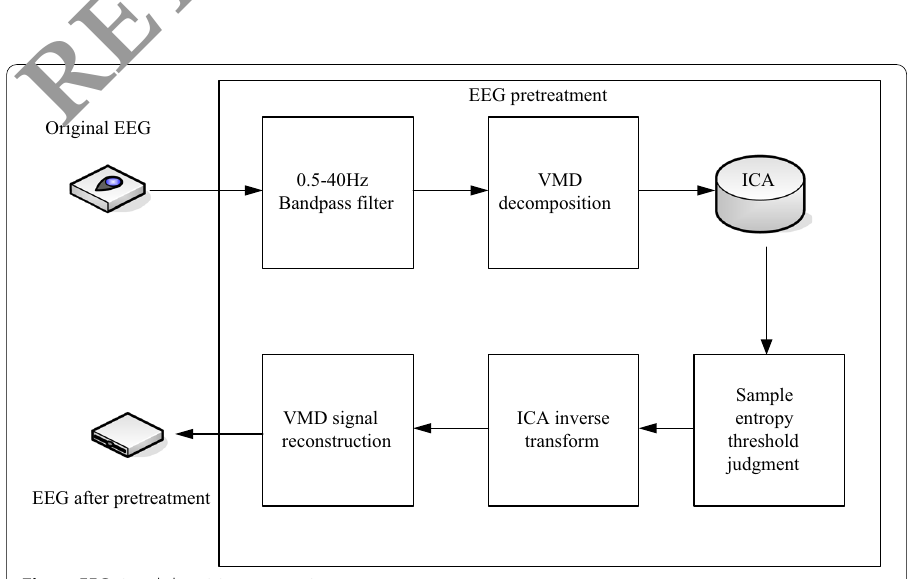
Fig. 1 EEG signal denoising processing